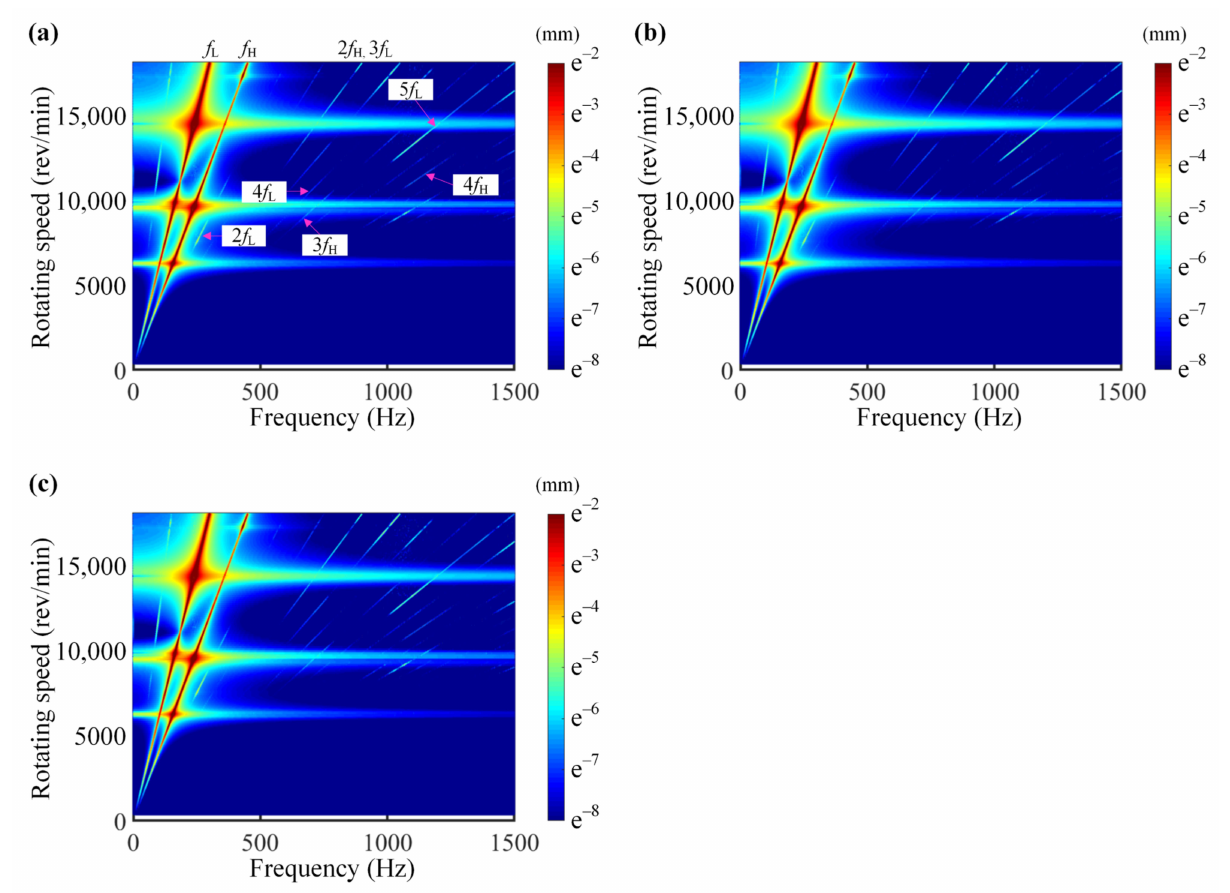
Figure 18. Spectrum cascades of ( a ) prototype and the prediction results from the models ( b ) M1 and ( c ) M2 under